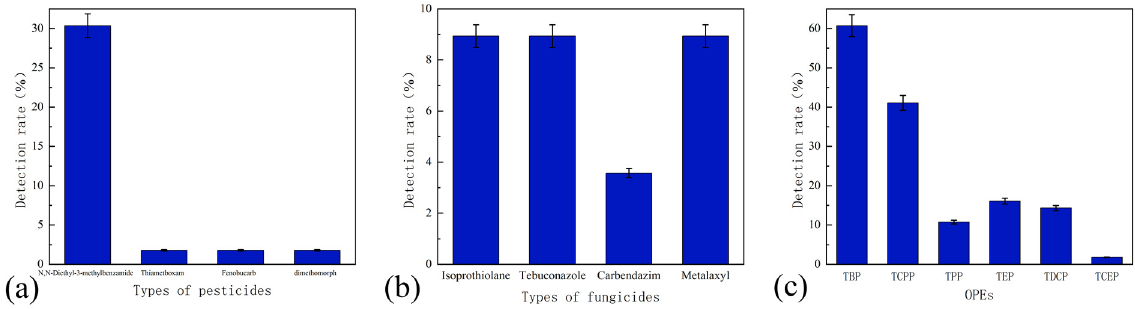
Figure 11. Detection map of organic micropollutants: ( a ) pesticides, ( b ) fungicides and ( c )